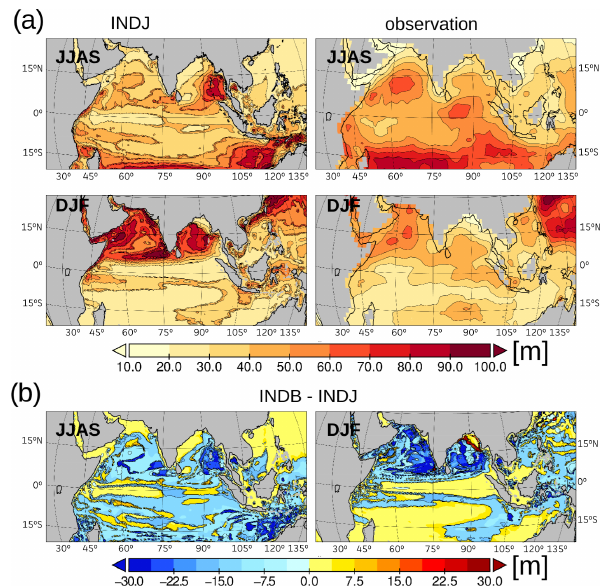
Figure 8. (a) Upper panel: monsoon season (JJAS) mixed-layer depth as calculated in the INDJ experiment (left) and from observa- tional data (de Boyer Montégut al., 2004; right). Lower panel: same as upper panel but for the winter season (DJF). (b) Mixed-layer depth difference between two model simulations (INDB–INDJ) for monsoon (left) and winter (right) seasons. All fields are time- averaged seasonally (DJF, JJAS) for the period